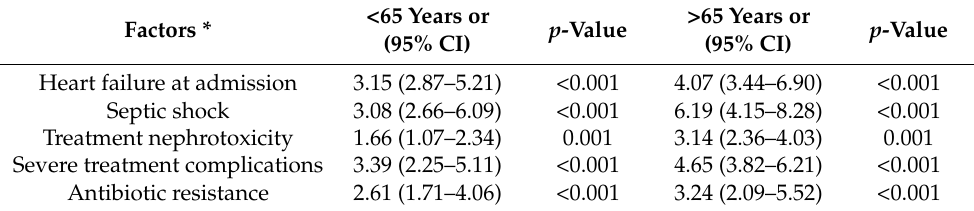
Table 6. Identification of significant risk factors for mortality in the patients with endocarditis. <65 Years or p Factors * (95% CI)